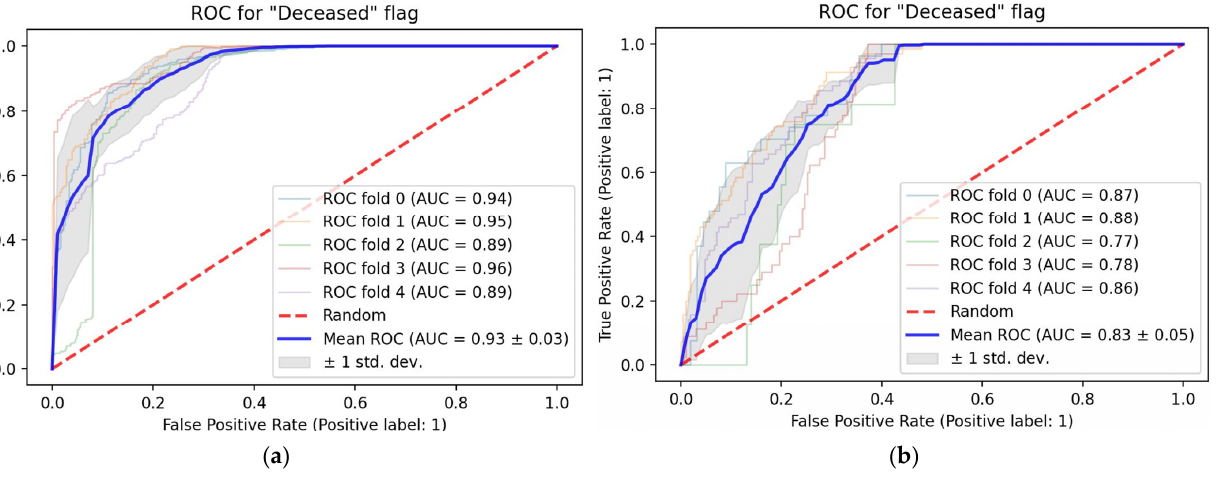
Figure 5. ROC curves showing performance of the prediction model utilizing combined imaging and non-imaging clinical data following partitioning based on ICU admission status. ( a ) Test performance with the ICU subgroup; ( b ) test performance with the non-ICU subgroup.